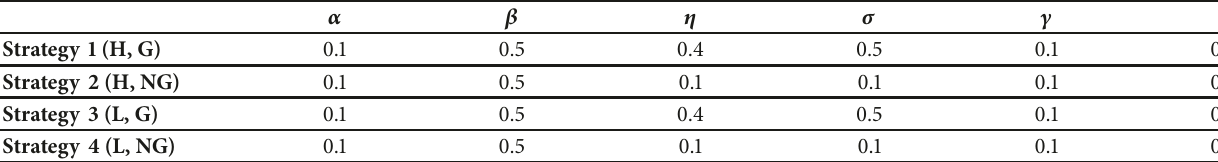
Table 3: Parameters assignment of rational audiences.